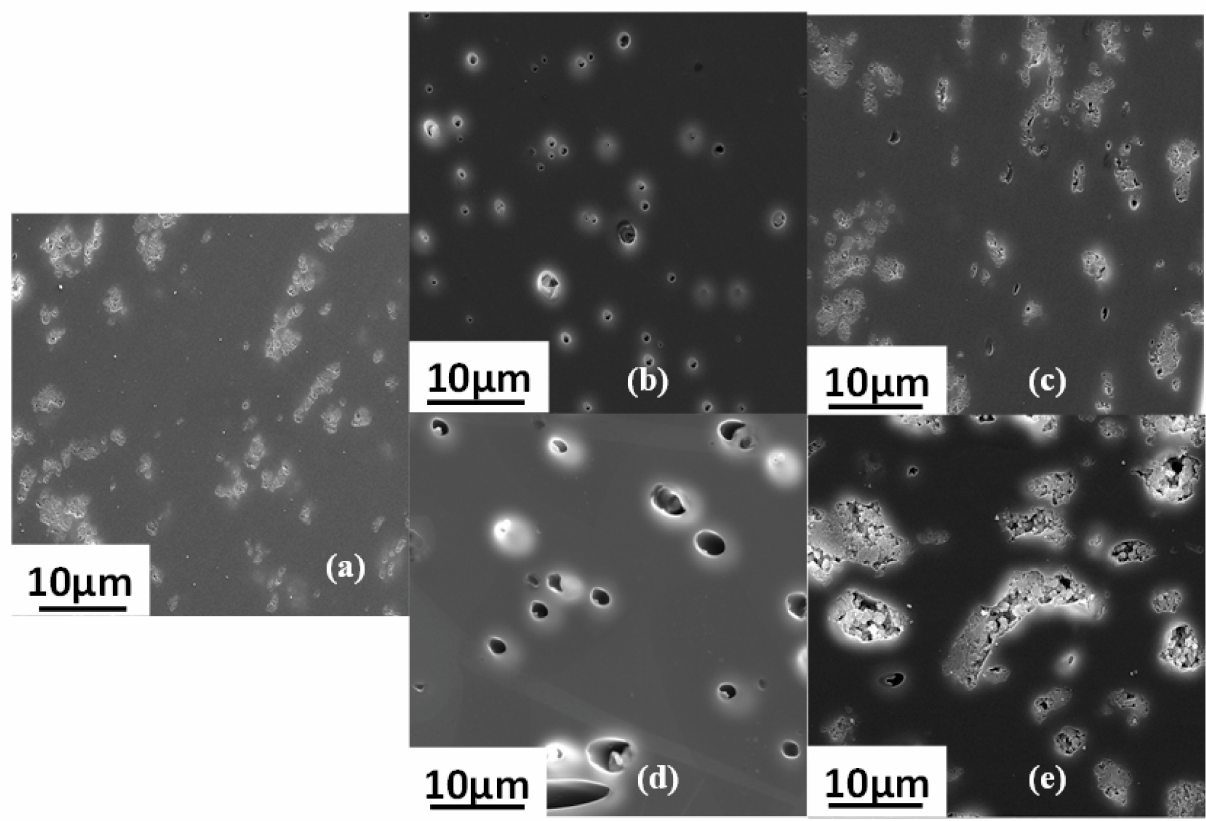
Figure 11. SEM images of the membranes cross sections: ( a ) PEI/10 ZIF-8; ( b ) PEI/2.5 IL; ( c ) PEI/2.5 IL/10 ZIF-8; ( d ) PEI/7 IL; and ( e ) PEI/7 IL/10